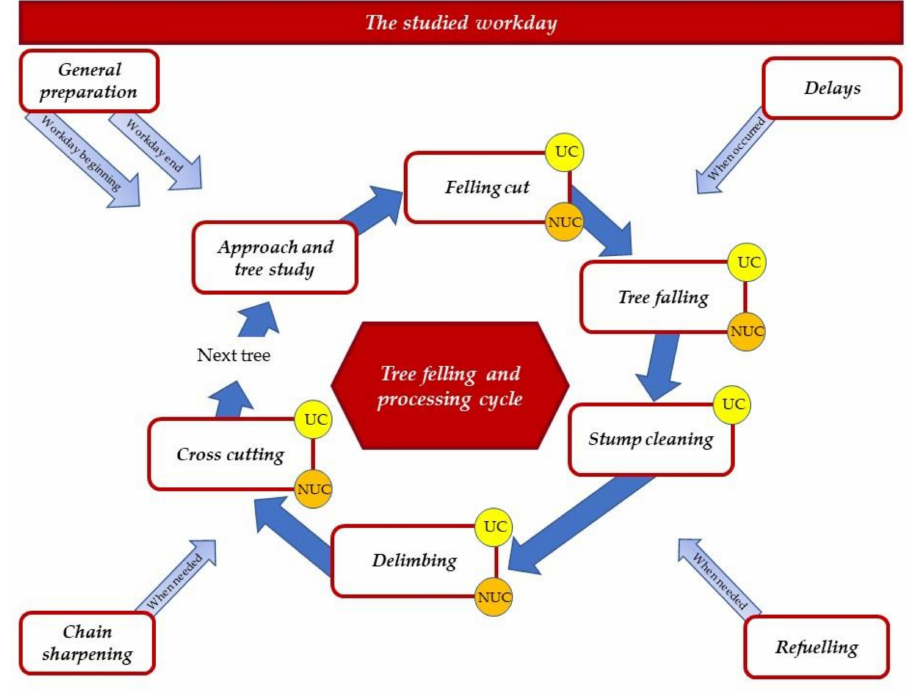
Figure 1. Time study flowchart. UC = using chainsaw, NUC = not using